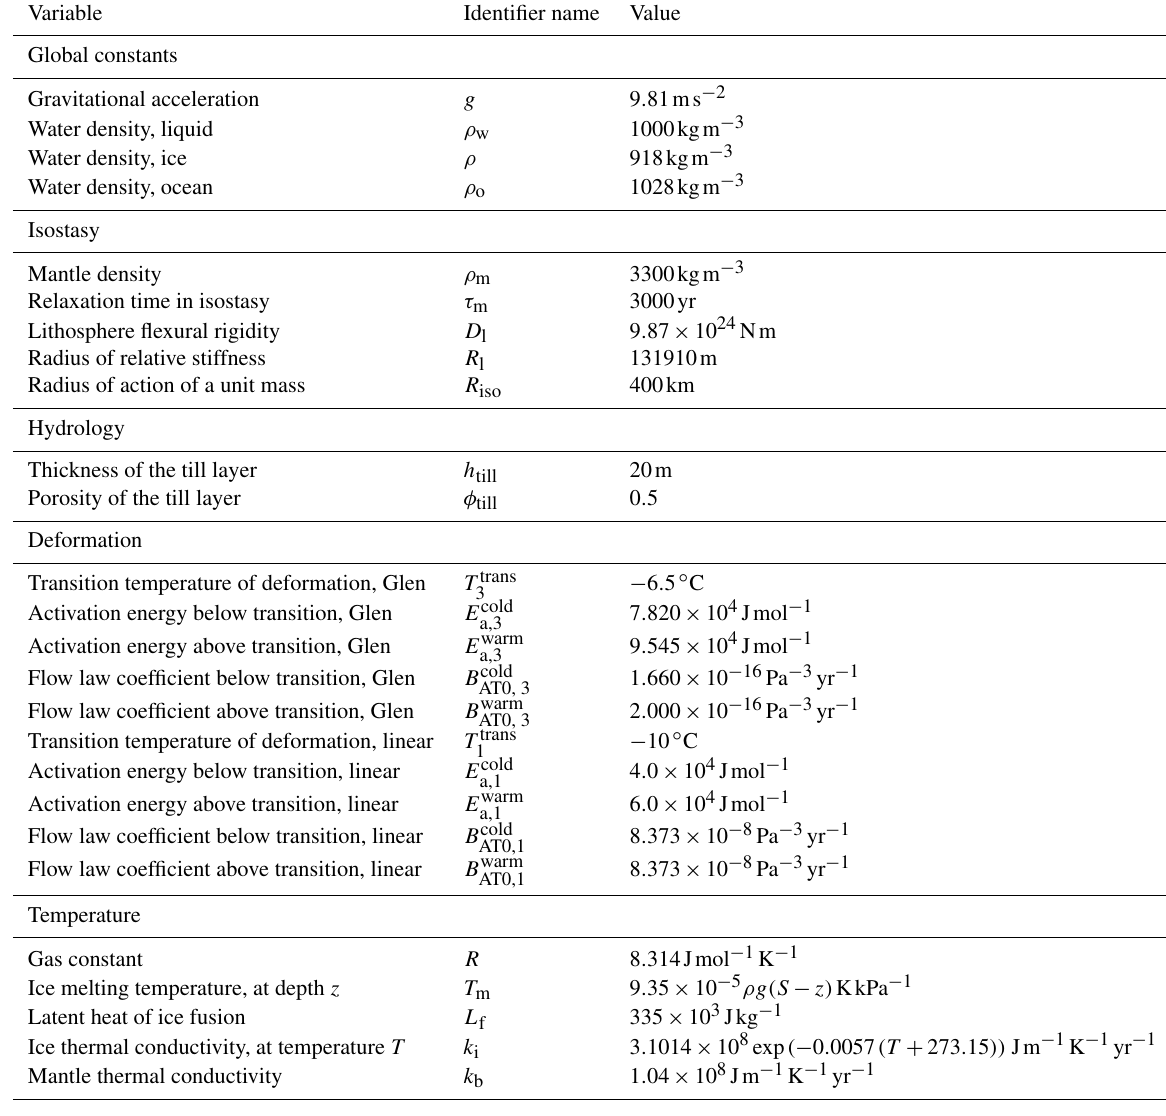
Table 1. GRISLI model parameters used in this